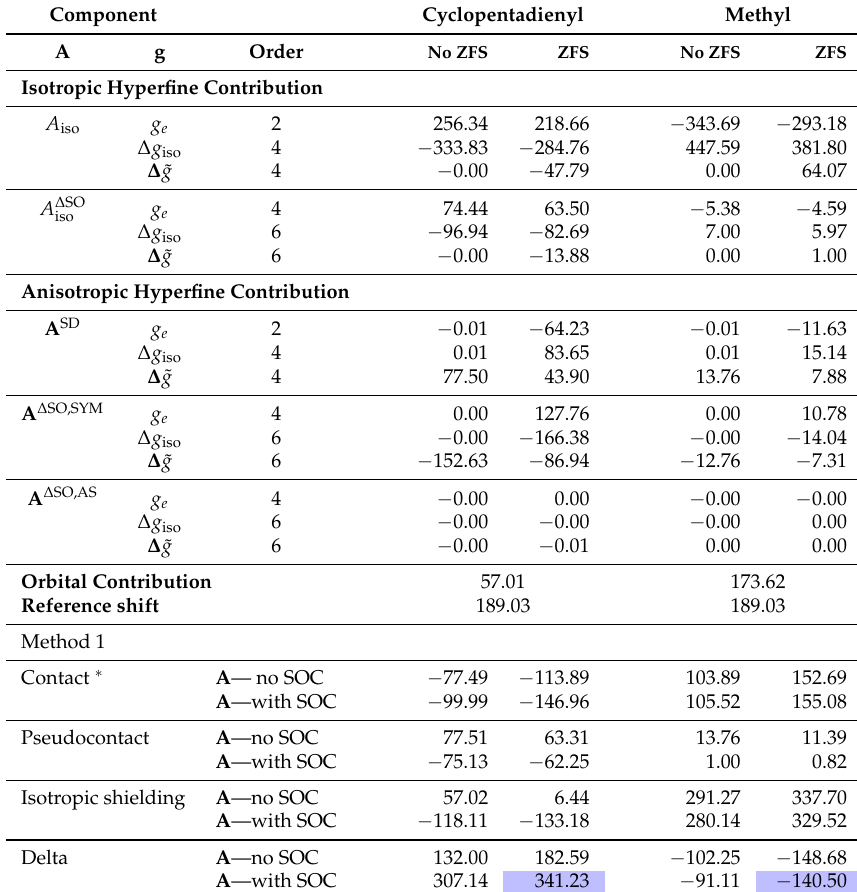
Table 10. Calculated 13 C pNMR shifts for U(C 5 Me 5 ) 3 in ppm with spin-orbit corrections to the hyperfine term at 298 K). The final, ZFS corrected, computational values are